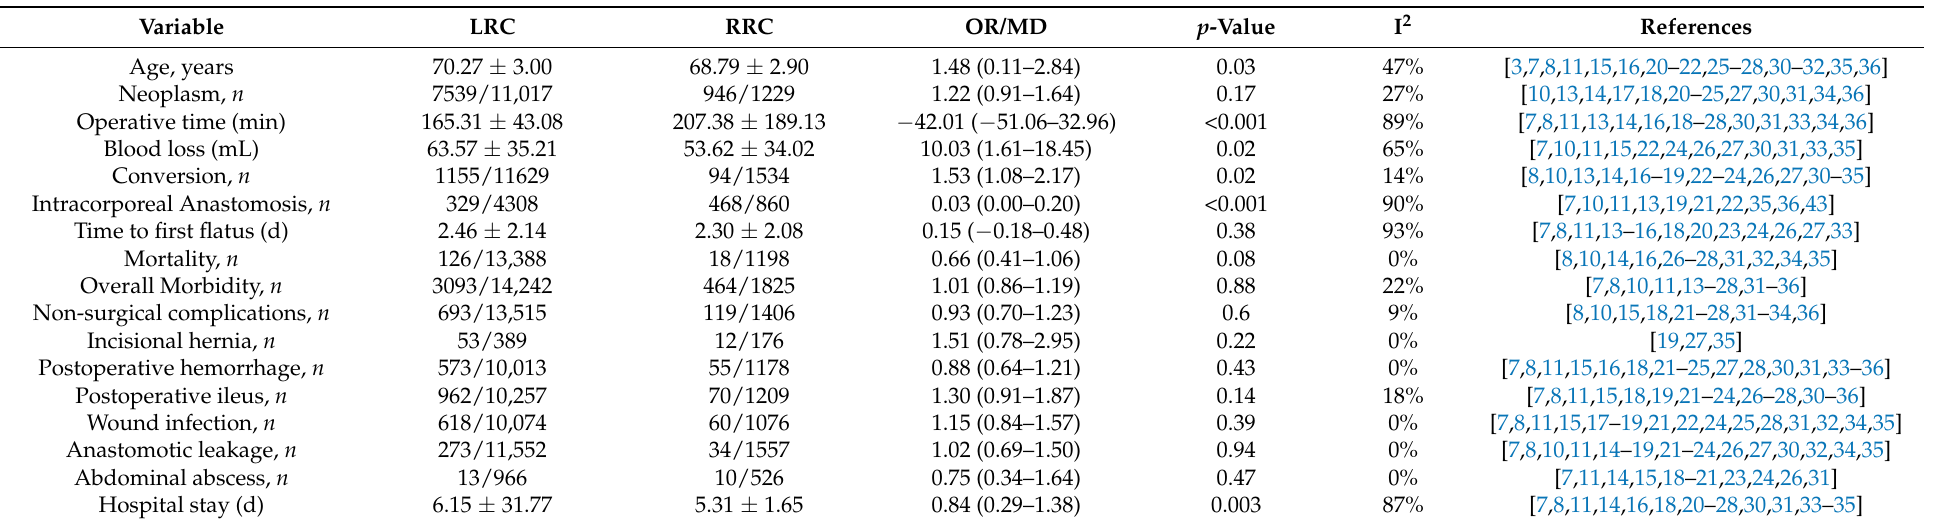
Table 3. Meta-analysis of perioperative outcome of included studies.